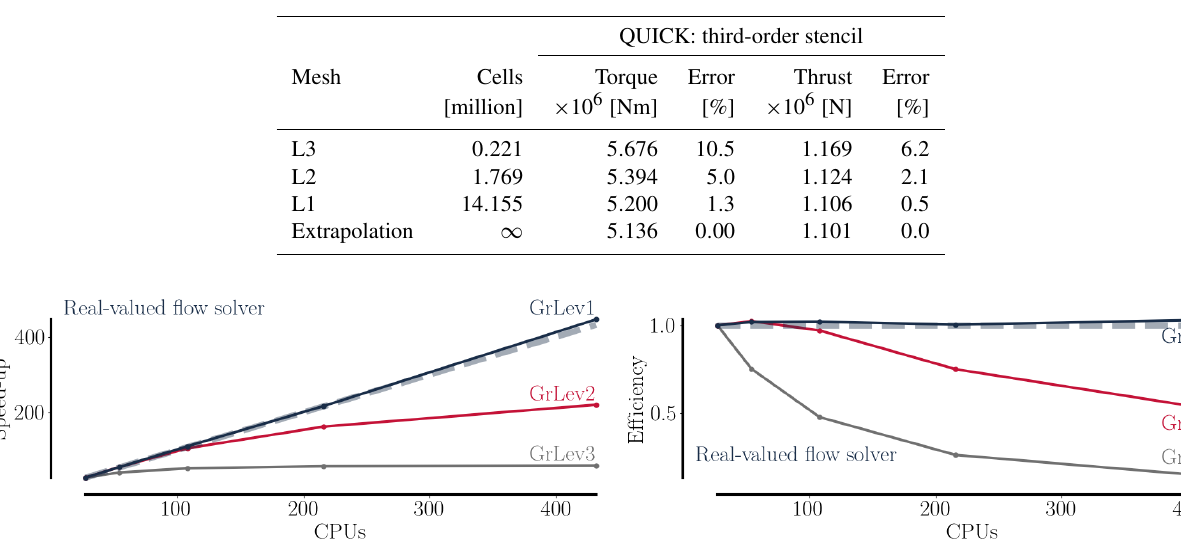
Figure 6. Measured scaling on the Sophia cluster for the EllipSys3D flow solver on the modified baseline mesh using 27, 54, 108, 216, and 432 CPUs. For the L2 mesh it seems up to 108 CPUs will result in very efficient CPU usage. For L1, which is by far the most interesting and time-consuming mesh level, the scaling is ideal, and up to 432 CPUs can advantageously be used. On L3 the mesh is so coarse that the computational task is modest, making scaling on this mesh level less